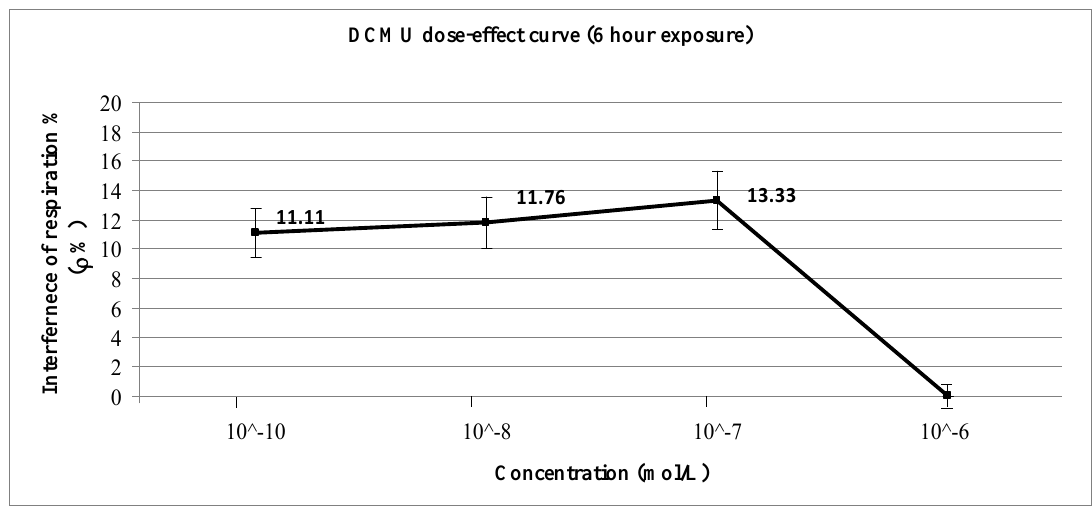
Figure 2. Dose-effect curve for short-term (6 h) exposure to diuron